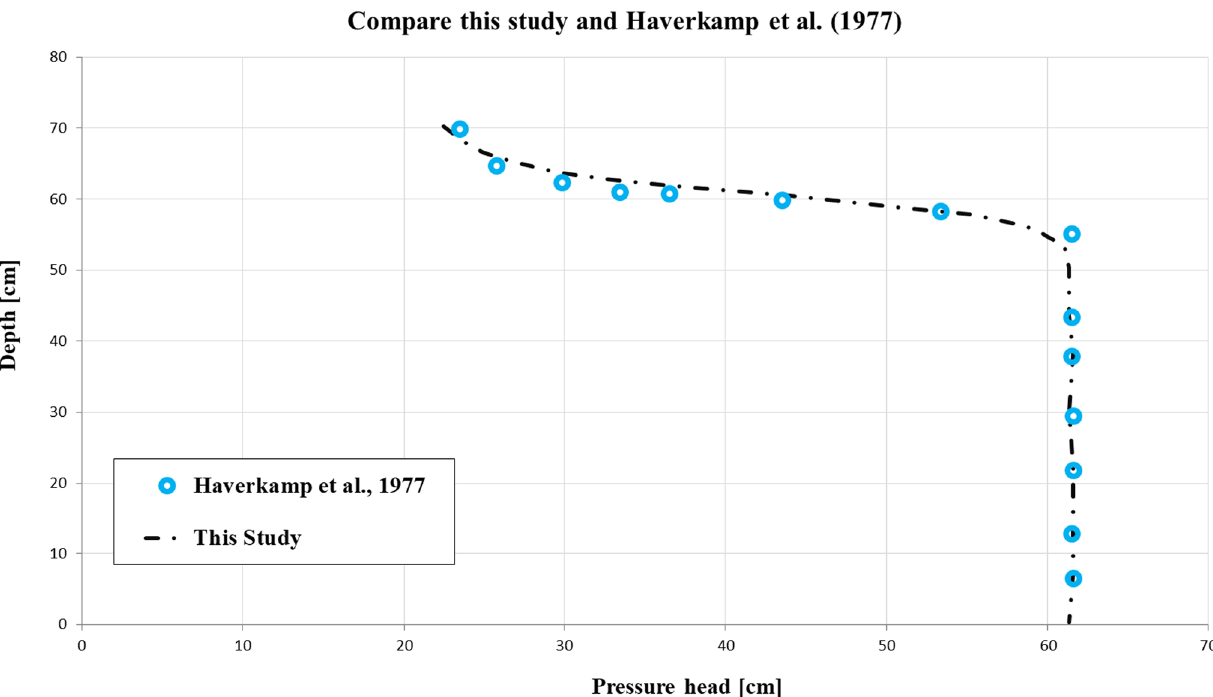
Fig. 3 Comparison of the suction profile modeled by meshless Petrov–Galerkin method and the laboratory data (Havercamp et al.